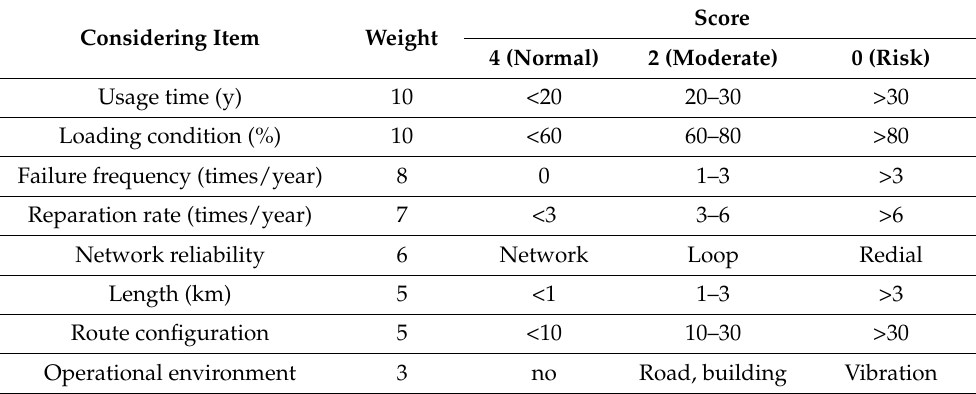
Table 2. Criteria with scoring and weighting values for conditional factor